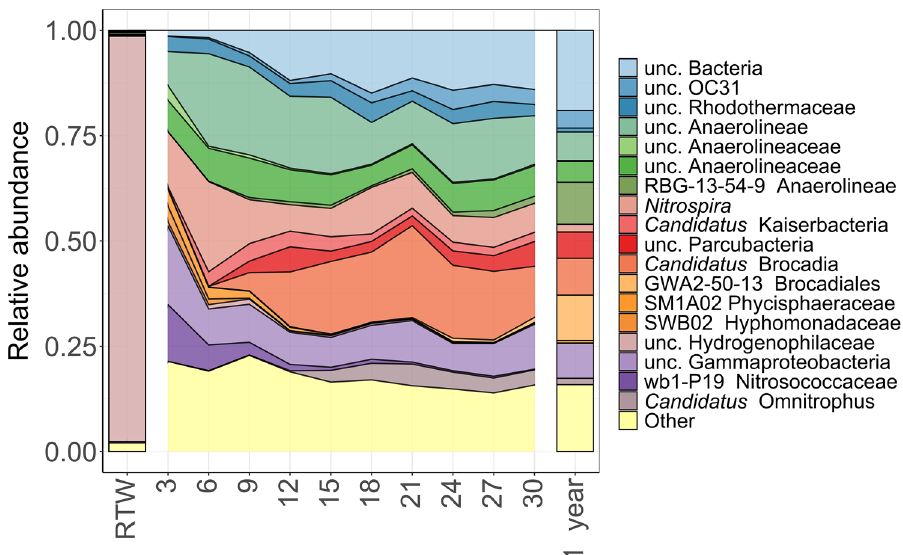
Figure 3. Percentile distribution of amplicon sequences on genus level revealed from the RTW sample and changes in the bacterial composition of biofilm communities in the one year period based on the 16S rRNA gene amplicon sequence data. Genera having < 2% relative abundance are combined in the “Other”